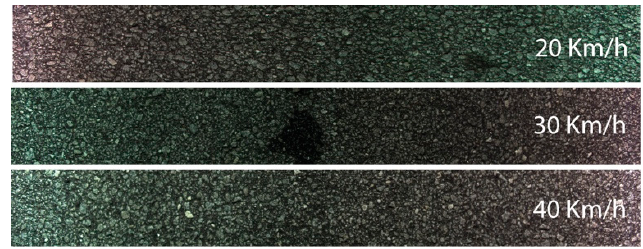
Figure 12. Image acquired at various travel speeds showing no loss or deterioration of the image quality.